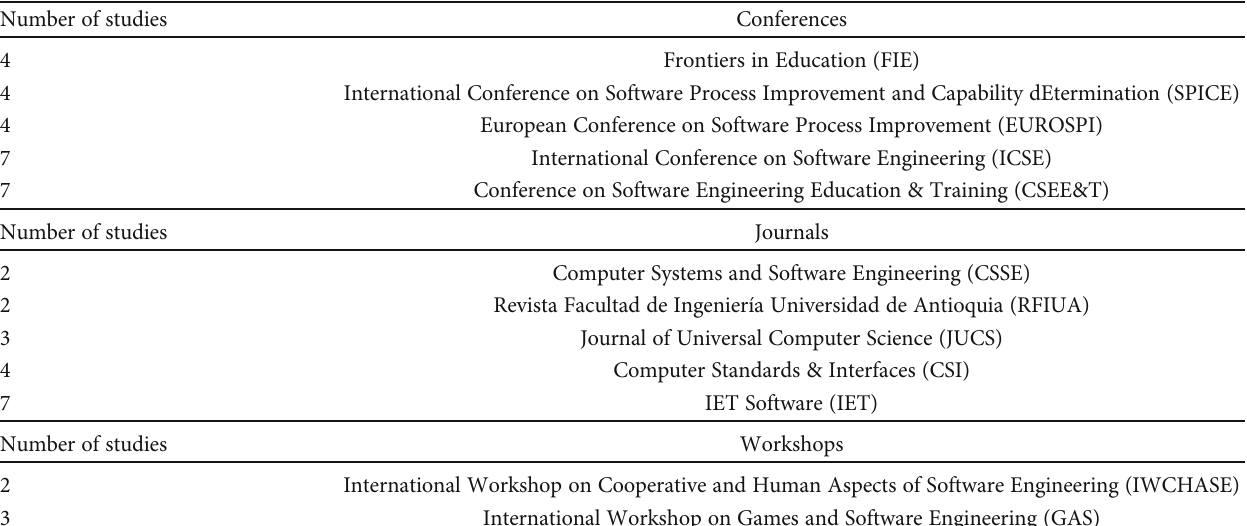
Table 8: Publication venues.